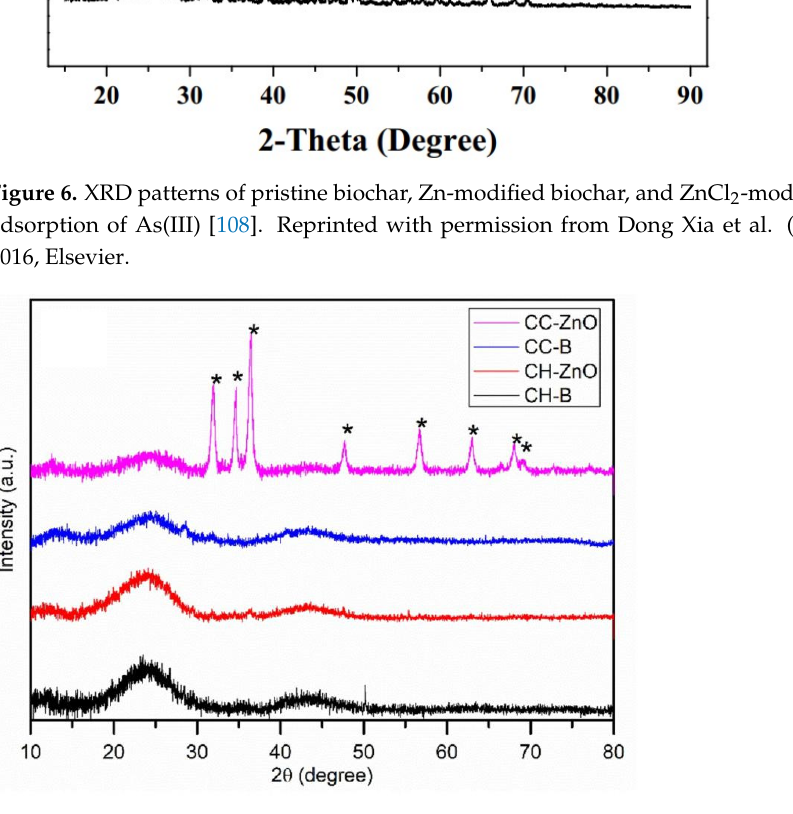
Figure 7. Diffraction pattern of XRD patterns of CH-B, CH-ZnO, CC-B, and CC-ZnO [112].(* shows a combination of amorphous and crystalline structures) . Reprinted with permission from G.J.F.Cruz